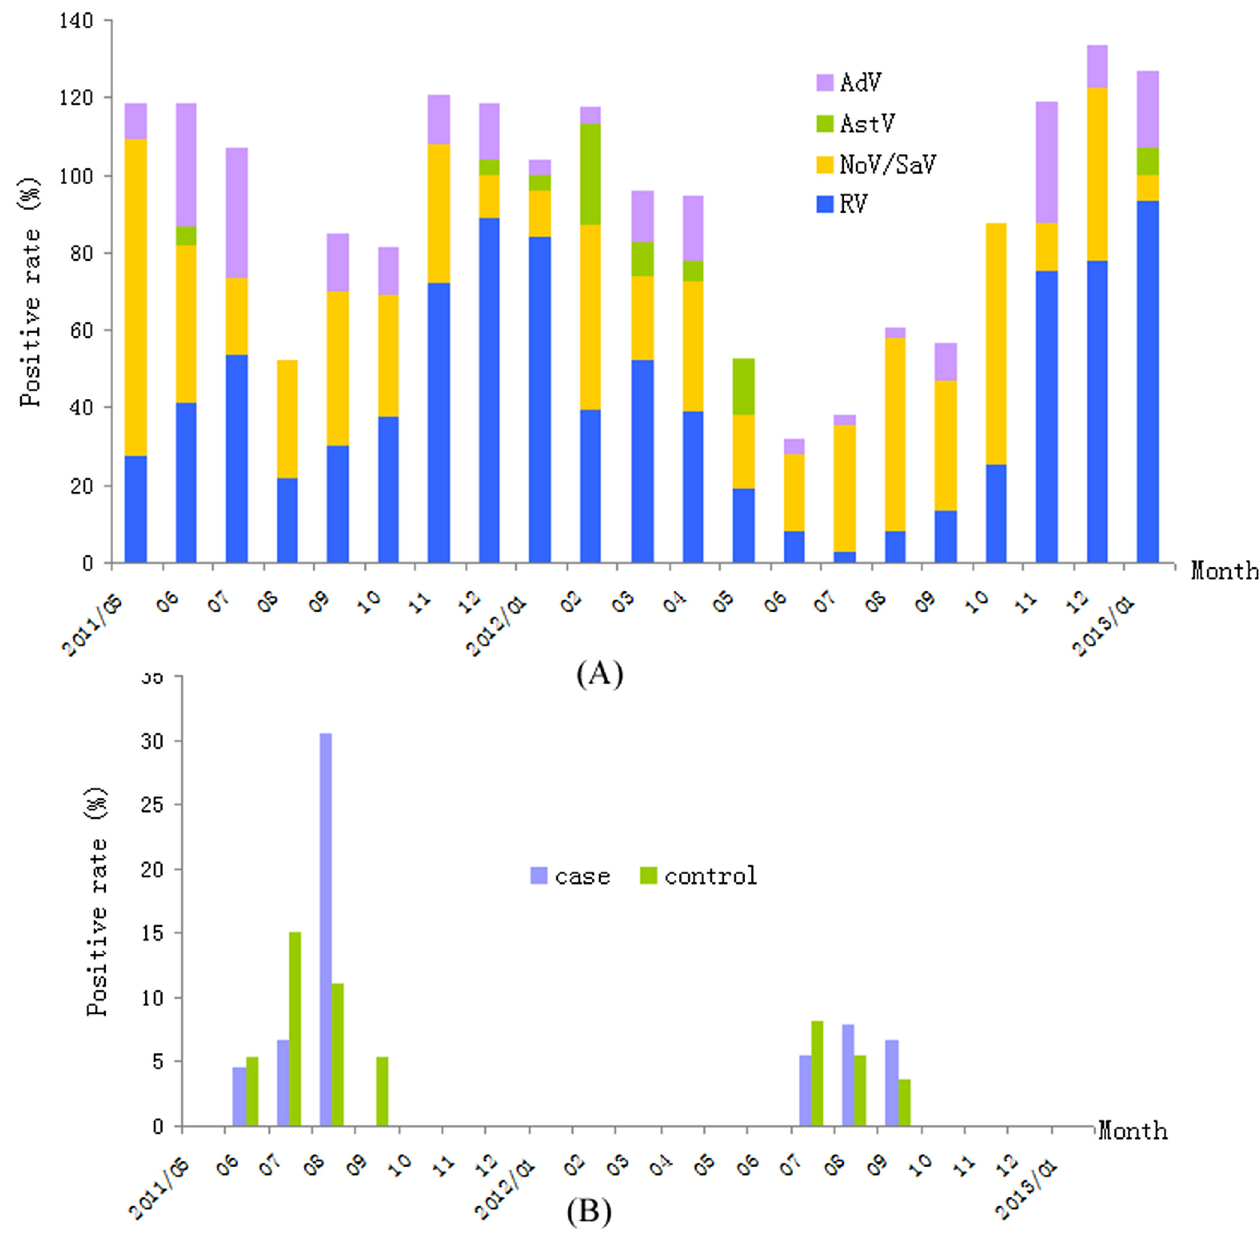
Fig 1. A. The monthly distribution of major viral pathogens in pediatric patients with gastroenteritis. RV peaked during the winters in the two years, NoV/SaV, AstV and AdV exhibited no marked seasonal distribution. B. The monthly distribution of salivirus in pediatric patients with gastroenteritis. The viruses in the case and control groups were detected in the hottest days of the year. Note: Y axis representing accumulating positive rate greater than 100% is due to some of the specimens were positive for more than one virus.